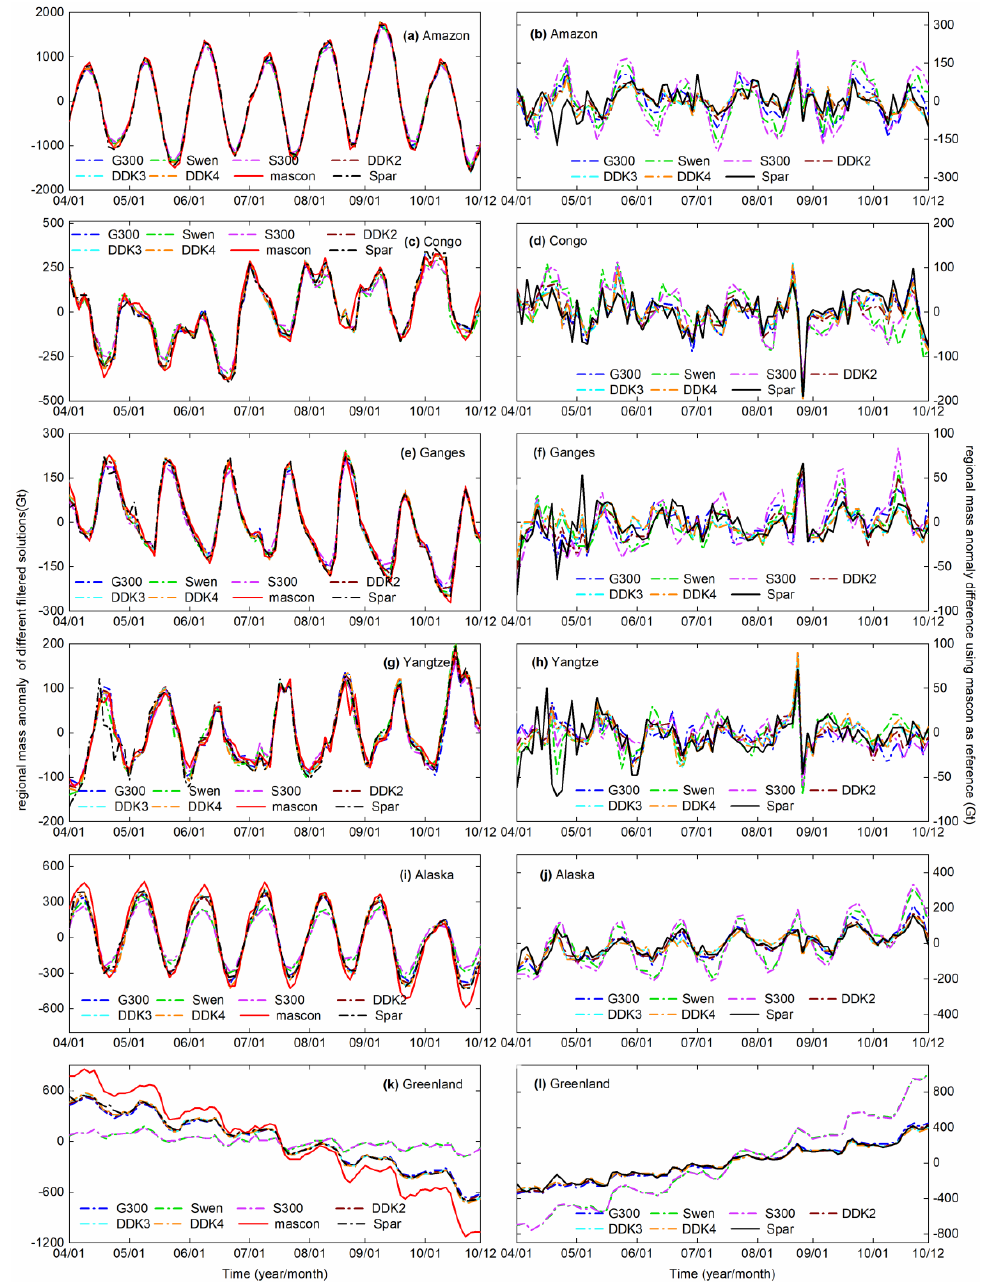
Figure 5. Variations of filtered regional mass anomalies vs. time ( left panel), and the corresponding differences with respect to the mascon solutions ( right panel). From top to bottom are results for Amazon Basin, Congo Basin, Ganges Basin, Yangtze Basin, Alaskan glaciers, and Greenland. No leakage correction is made for the filtered solutions.